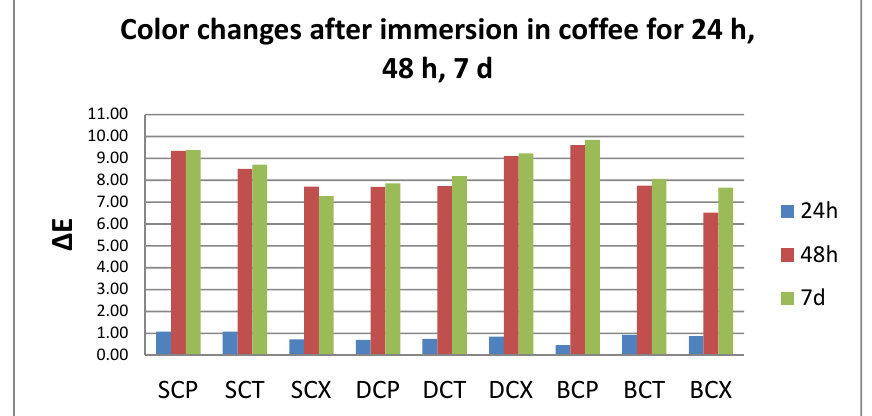
Figure 2. Mean values for ∆ E parameter for all the tested values after immersion in coffee.